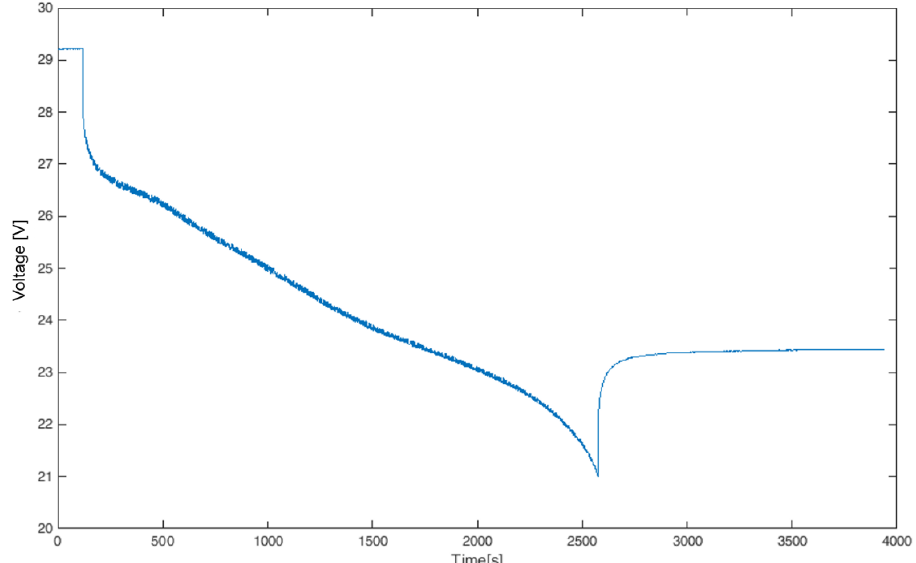
Figure 16. The voltage profile of the battery module during the 2C-rate discharge test.